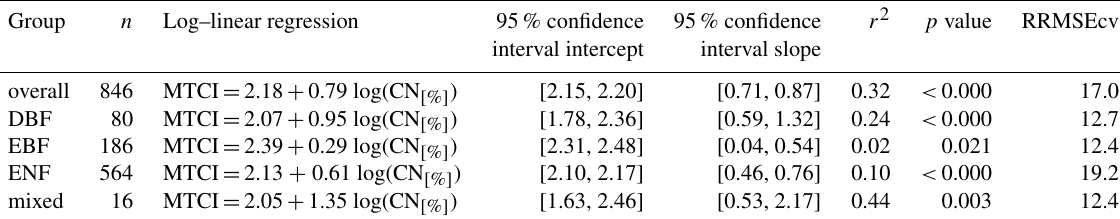
Figure 5. Scatterplot and log–linear regression line between the MTCI (–) and canopy nitrogen (N) concentration (canopy N [ % ] , %N) for (a) the whole dataset ( n = 846); (b) deciduous broadleaf forest plots (DBF, n = 80); (c) evergreen broadleaf forest plots (EBF, n = 186); (d) evergreen needleleaf forest plots (ENF, n = 564); (e) mixed forest plots ( n = 16). PFT is plant functional type. The grey shading represents the prediction intervals (95%). Canopy N [ % ] variable was log transformed to fulfil linear model assumptions. Table 3. Observed log–linear regression equations between the MTCI (–) and canopy nitrogen concentration (CN [ % ] , %N) for different subgroups. Number of plots ( n ), determination coefficient ( r 2 ) , p value and relative root mean square error of cross validation (RRMSEcv) are shown. PFT is plant functional type, DBF is deciduous broadleaf forest, EBF is evergreen broadleaf forest, ENF is evergreen needleleaf forest, and mixed is mixed